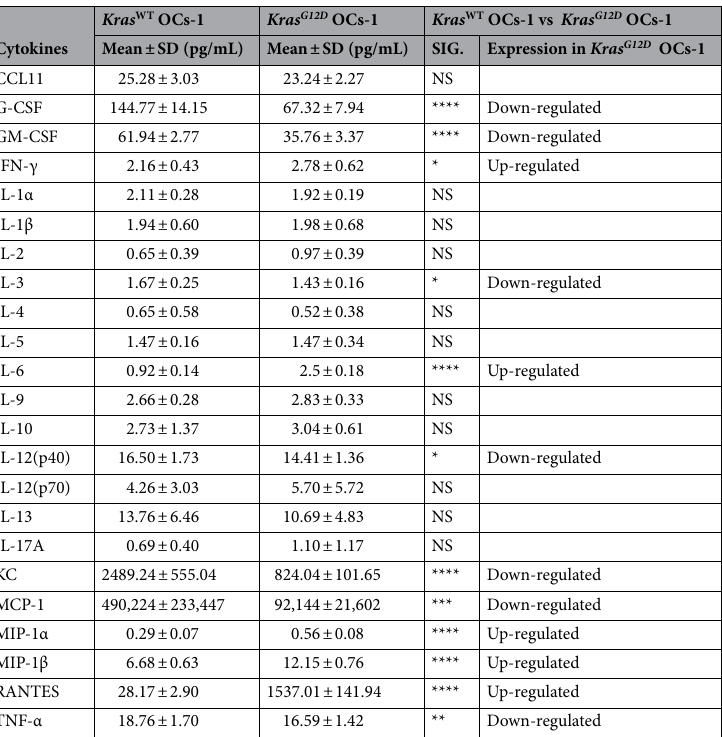
Table 1. Cytokines present in supernatants of OCs-1 Kras WT and Kras G12D OCs-1. *Student’s t -test, *p <